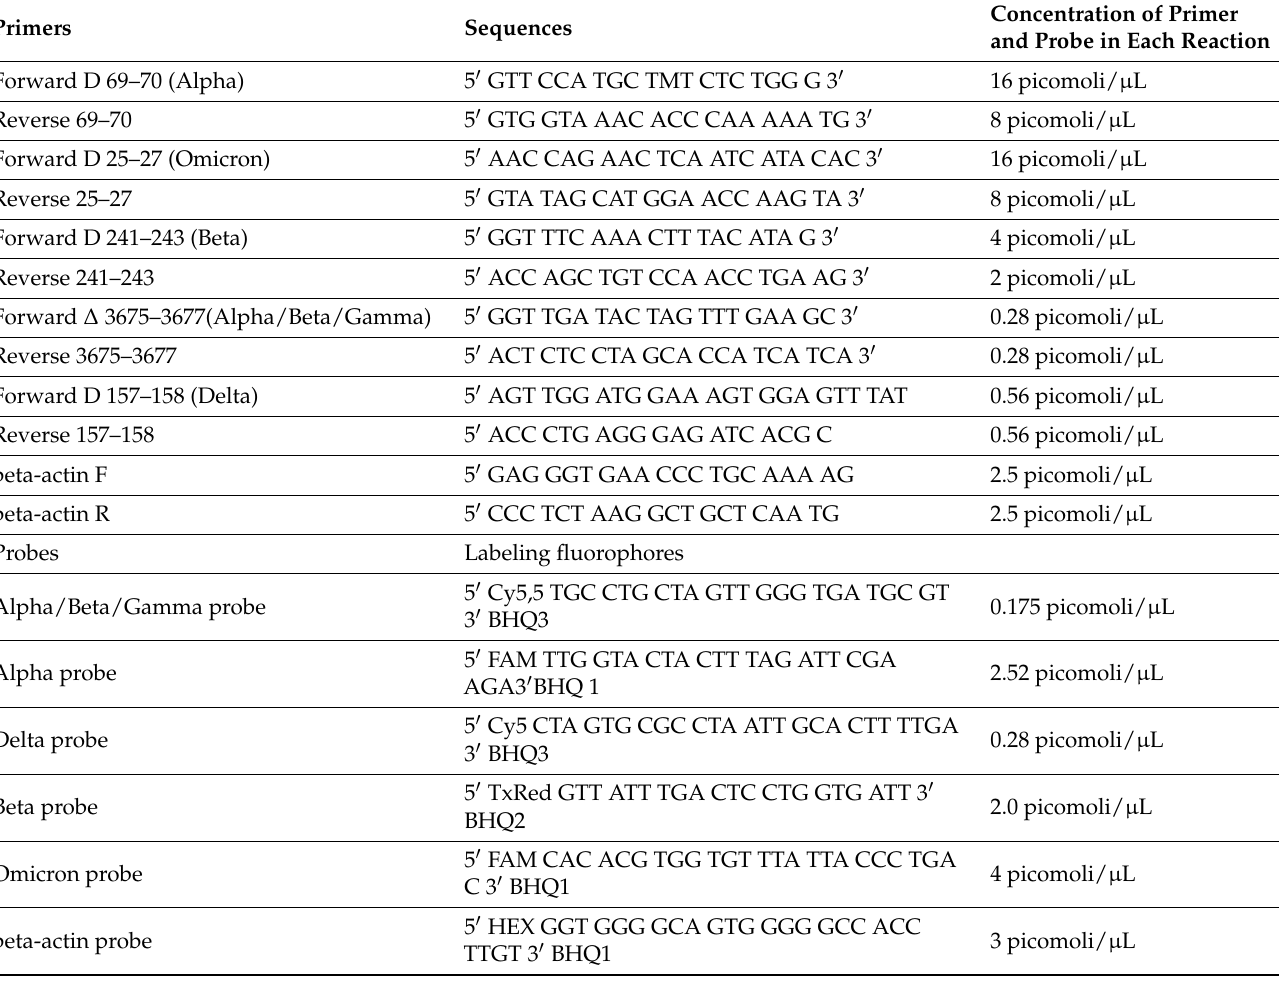
Table 1. List of primers, probes, and their concentrations used in our assay. Sequences